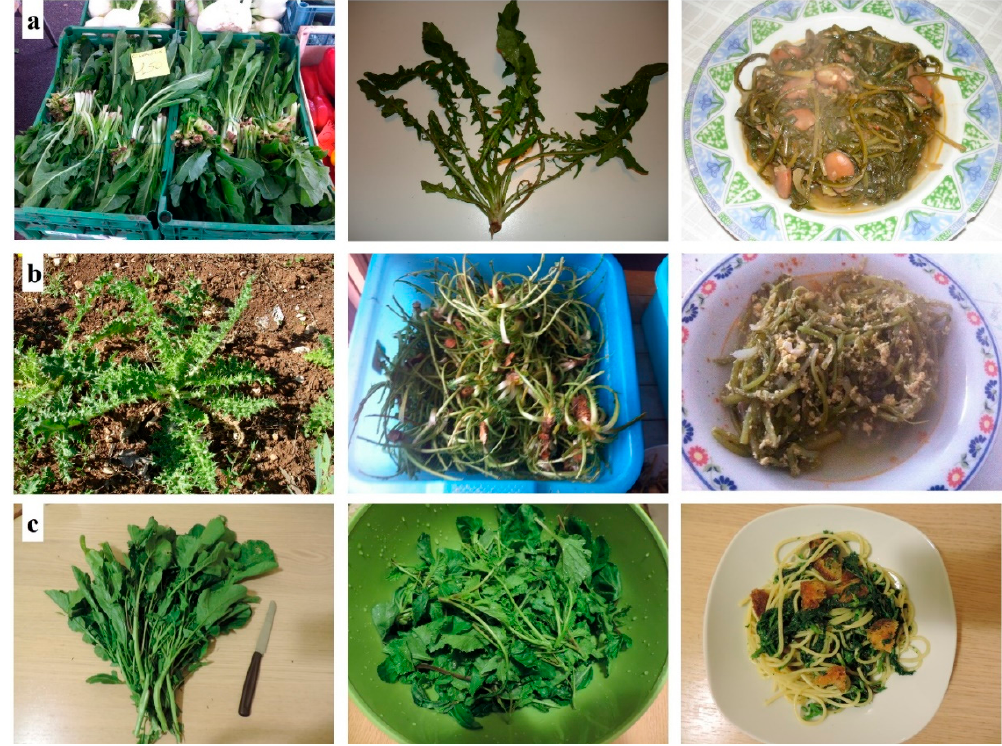
Figure 2. ( a ) Wild chicory ( Cichorium intybus L.) leaves sold in a local farmer’s market in Puglia